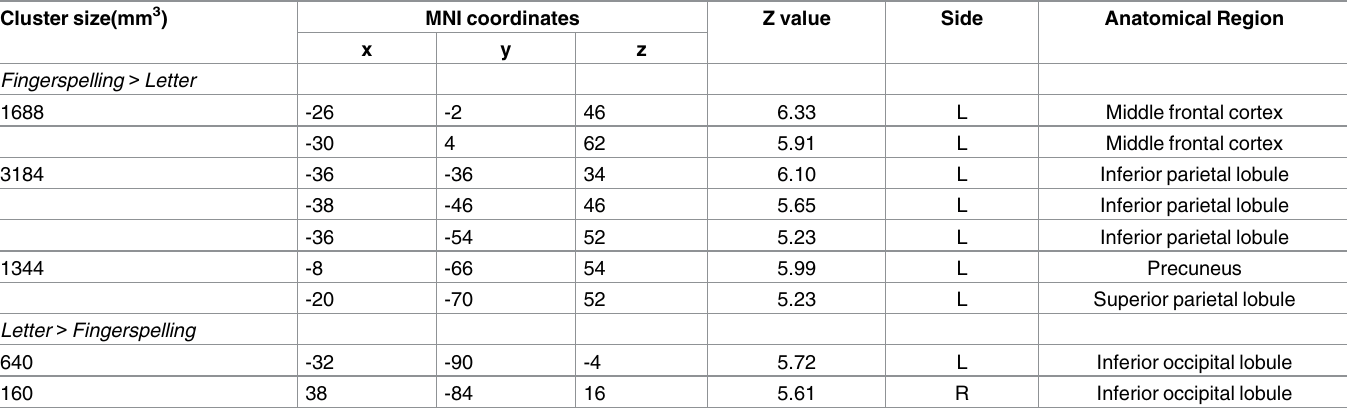
Table 2. Modality-specific activations during the maintenance stage. Cluster size(mm 3